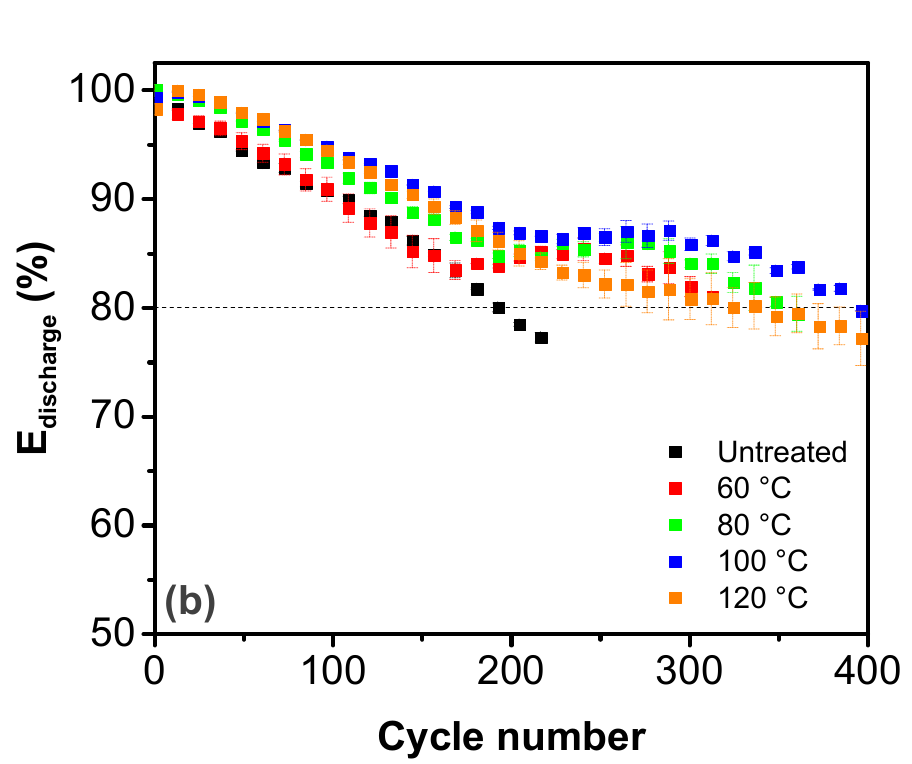
Figure 8. Mean value and standard deviation of ( a ) specific discharge-capacity retention and ( b ) specific discharge-energy retention of the synthesized CuHCF-based electrodes galvanostatically cycled at 1C annealed at different temperatures. The mean value and the standard deviations were calculated according to at least two different measurements of two different synthesis batches for each annealing